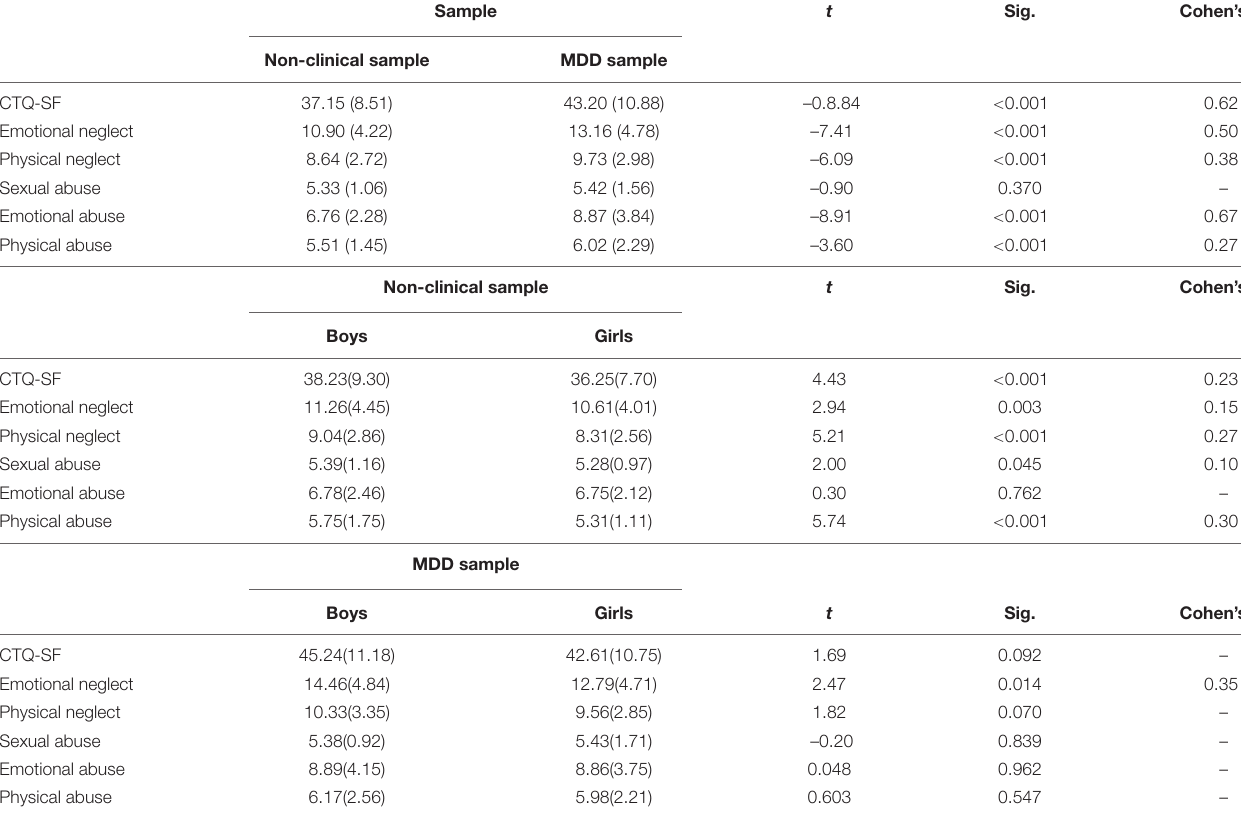
TABLE 11 | Childhood Trauma Questionnaire-Short Form mean score differences between